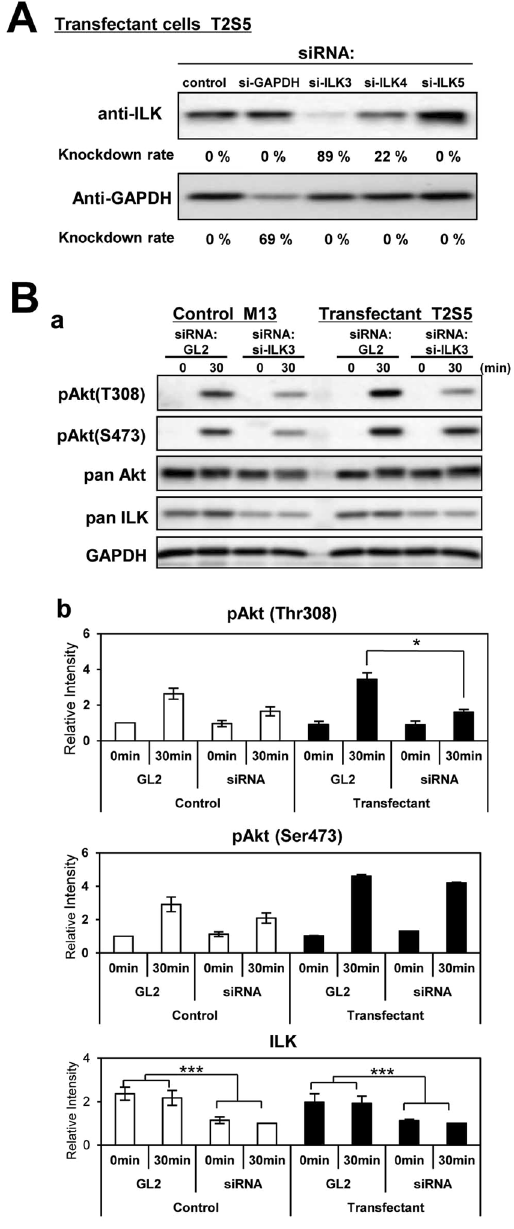
Figure 4. Reduction of Akt phosphorylation by ILK silencing. ( A ) Effects of siRNA for the knockdown of ILK on phosphorylation levels of Akt. Three kinds of anti-ILK siRNA and anti-GAPDH si-RNA as a control were analyzed. Si-ILK3 suppressed ILK levels efficiently (80~90%), and GL2 (anti-firefly luciferase siRNA) was used as a control. ( B ) Effects of ILK knockdown on phosphorylation levels of Akt in control cells and transfectants cells during adhesion to LN were examined. After 48 h of transfection, cells were plated on pre-coated LN, and lysed for immunoblotting at incubation time 0 and 30 min. Definite reduction in Akt phosphorylation was detected in the transfectant cells. Bars indicate mean ± S.D. (n = 3). * P < 0.05, ** P < 0.01, *** P < 0.005. These were representative results among experiments repeated at least 3 times with similar results ( A , B ). All cropped blots were run under the same experimental condition. The full-length blots are presented in Supplemental Figure